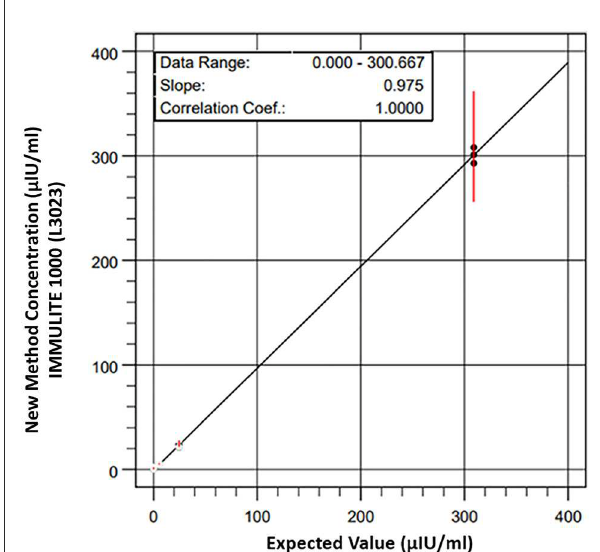
FIGURE1 Linearity of standard reference reagents for equine serum based-insulin solutions measured by Immulite ® 1000 CLIA using equine serum-based control solutions was excellent, showing a strong relationship between the expected and measured concentrations of the diluted samples. Linear regression at analyzed concentrations indicated the best fit line as y = 0.975 x – 0.585 ( r = 0.999, P < 0.0001). The analytical range of the Immulite ® 1000 CLIA was 0 to 300 µ